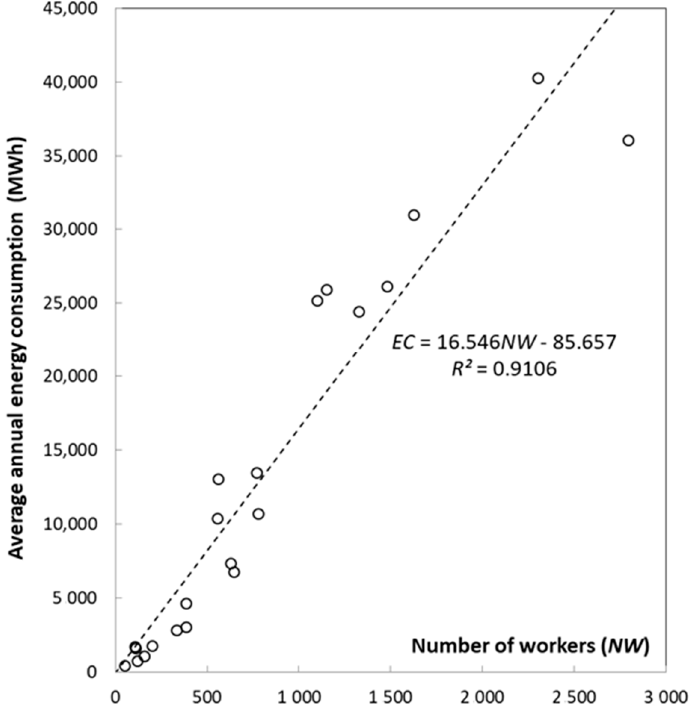
Figure 4. The ratio of average annual energy consumption and number of workers per hospital.